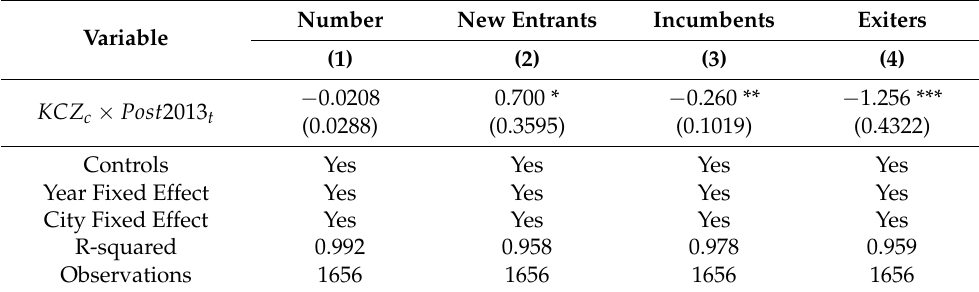
Table 5. Mechanism